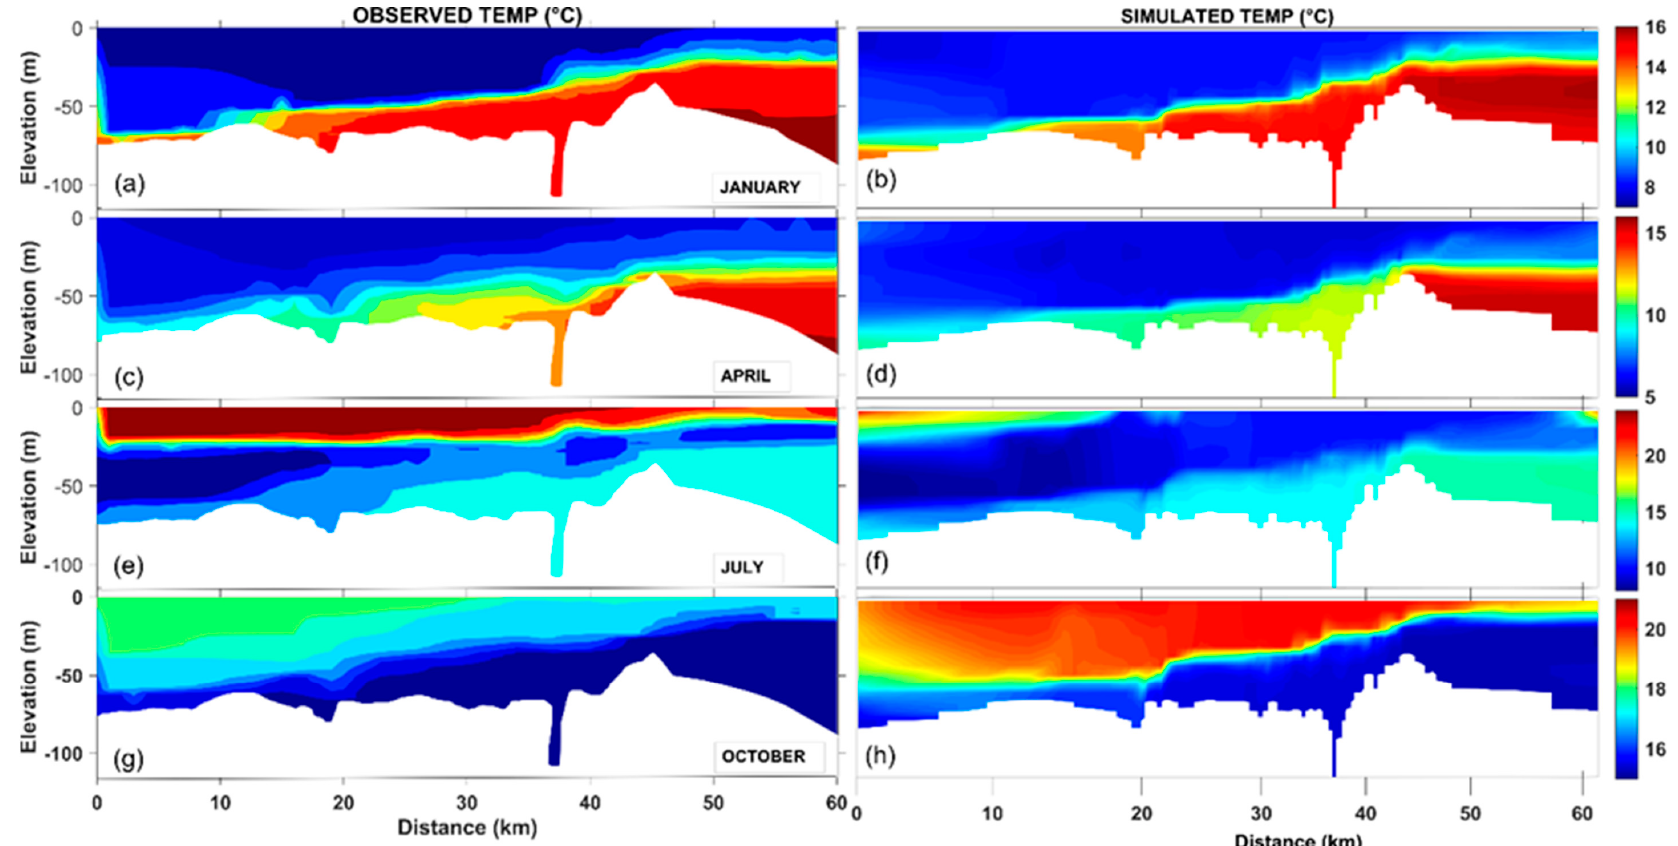
Figure 10. Temperature profiles observed ( a ) and modeled ( b ) in January, observed ( c ) and modeled ( d ) in April, observed ( e ) and modeled ( f ) in July, and observed ( g ) and modeled ( h ) in October.